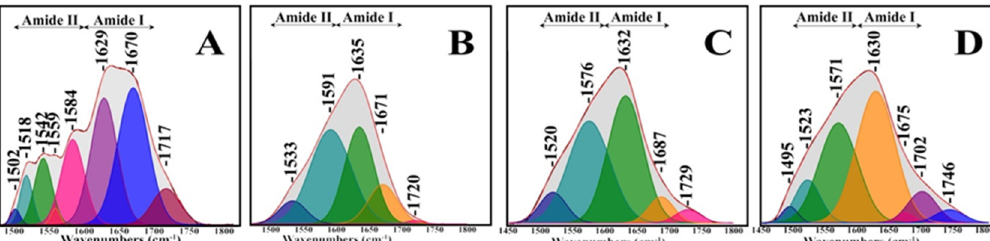
Figure 2. Deconvoluted amide I–amide II broad band from the free extracellular polymeric substance (EPS) of the bacterial capsule of A. ferrooxidans ( A ) and the bio-interacted system of A. ferrooxidans —chalcopyrite mineral in the spectral region of 1500–1800 cm − 1 . FTIR measurements were recorded at three ( B ), six ( C ) and seven ( D ) weeks during the bioleaching. Table 1. Assignments of the subcomponent bands of the amide I–amide II peaks of free EPS of the bacterial capsule of A. ferrooxidans in the spectral range of 1500–1800 cm − 1 . Component Band